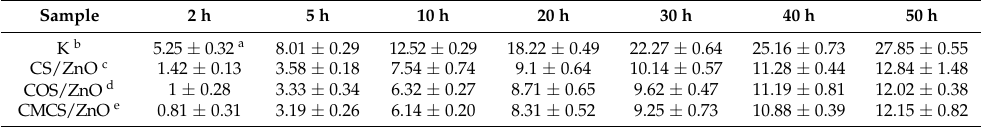
Table 1. ∆ E changes in different chitosan forms of composite-treated wood at different irradiation times.